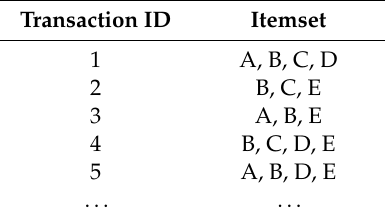
Table 1. Transaction consists of Transaction ID and Itemset.